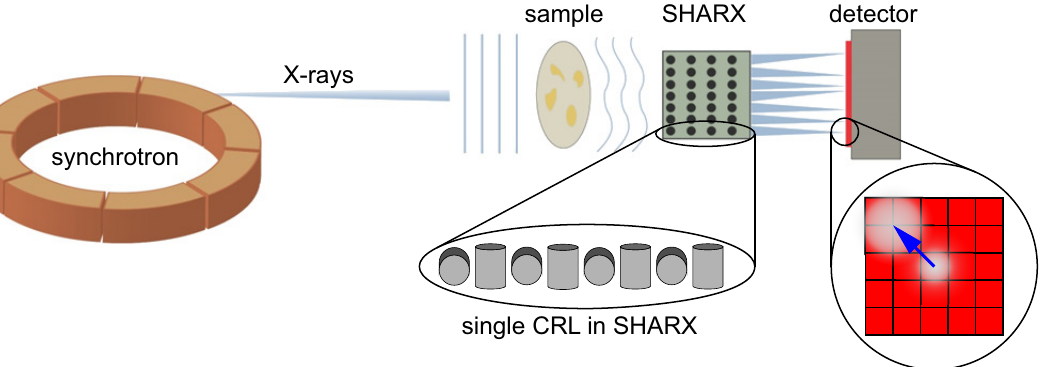
Figure 2. Schematic illustration of the experimental setup with the flat X-ray beam coming from the synchrotron getting disturbed by the sample and consequently analyzed by the Shack-Hartmann sensor for hard X-rays (SHARX) and measured by the detector. The crossed cylinder lenses lead to small spots on the detector which may get shifted, broadened or/and attenuated as depicted by the blue arrow. CRL: compound refractive X-ray